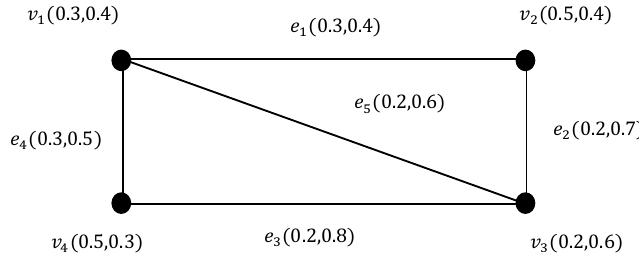
Figure 3.1: Perfect edge domination set